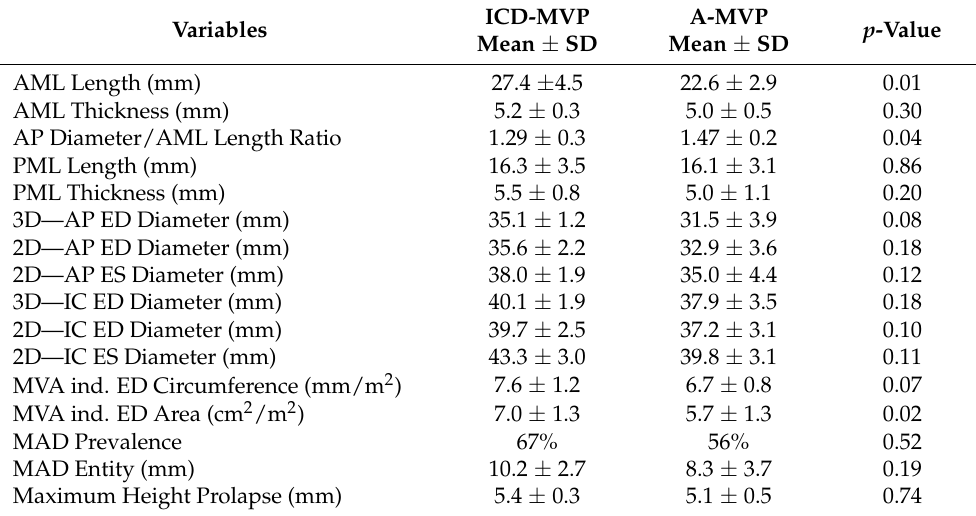
Table 2. Anatomical echocardiographic parameters compared in ICD-MVP group and A-MVP group.